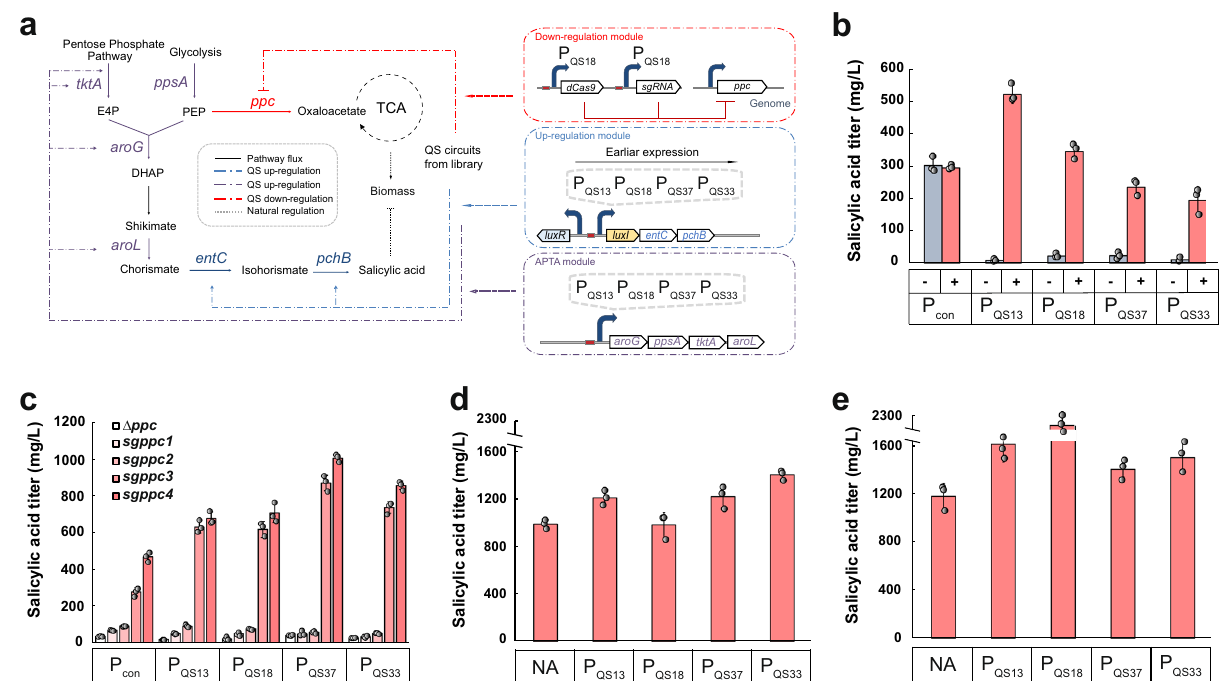
Fig. 4 Enhancement of SA production by dynamically and simultaneously controlling multiple metabolic fl uxes. a Schematic construction of layered dynamic control circuits for regulation of the SA biosynthetic pathway. b The effect of different triggering OD of QS variants driving entC-pchB expression on SA titer. Gray bars represent SA titers generated by the strains harboring partial QS circuits in the absence of the gene luxI . Red bars represent SA titers generated by the strains harboring entire QS circuits in the presence of the gene luxI . c The effect of different triggering OD of QS variants driving entC-pchB combined with different ppc downregulation levels on SA titer. d The effect of three-layered dynamic regulation strategy on SA titer in wildtype E. coli strain. The upregulation module containing SA pathway genes was controlled by the QS variant P QS37 , the downregulation module carrying the CRISPRi system was controlled by the QS variant P QS18 , and the APTA module was controlled by QS variant P QS13 , P QS18 , P QS37 , or P QS33 , respectively. e The effect of three- layered dynamic regulation strategy on SA titer in QH4 strain. The upregulation module containing SA pathway genes was controlled by the QS variant P QS37 , the downregulation module carrying the CRISPRi system was controlled by the QS variant P QS18 , the APTA module was controlled by QS variant P QS13 , P QS18 , P QS37 , or P QS33 , respectively. NA represents the SA titer generated by the control strain lacking the APTA module. Genes: tktA encodes transketolase, ppsA encodes phosphoenolpyruvate synthase, aroG encodes 3-deoxy- D -arabinoheptulosonate-7-phosphate (DHAP) synthase, aroL encodes shikimate kinase, ppc encodes phosphoenolpyruvate carboxylase, entC encodes isochorismate synthase, pchB encodes isochorismate pyruvate lyase. Metabolites: E4P D -erythrose-4-phosphate, PEP phosphoenolpyruvate. Data shown are mean ± SD ( n = 3 independent experiments). Source data are provided as a Source Data fi